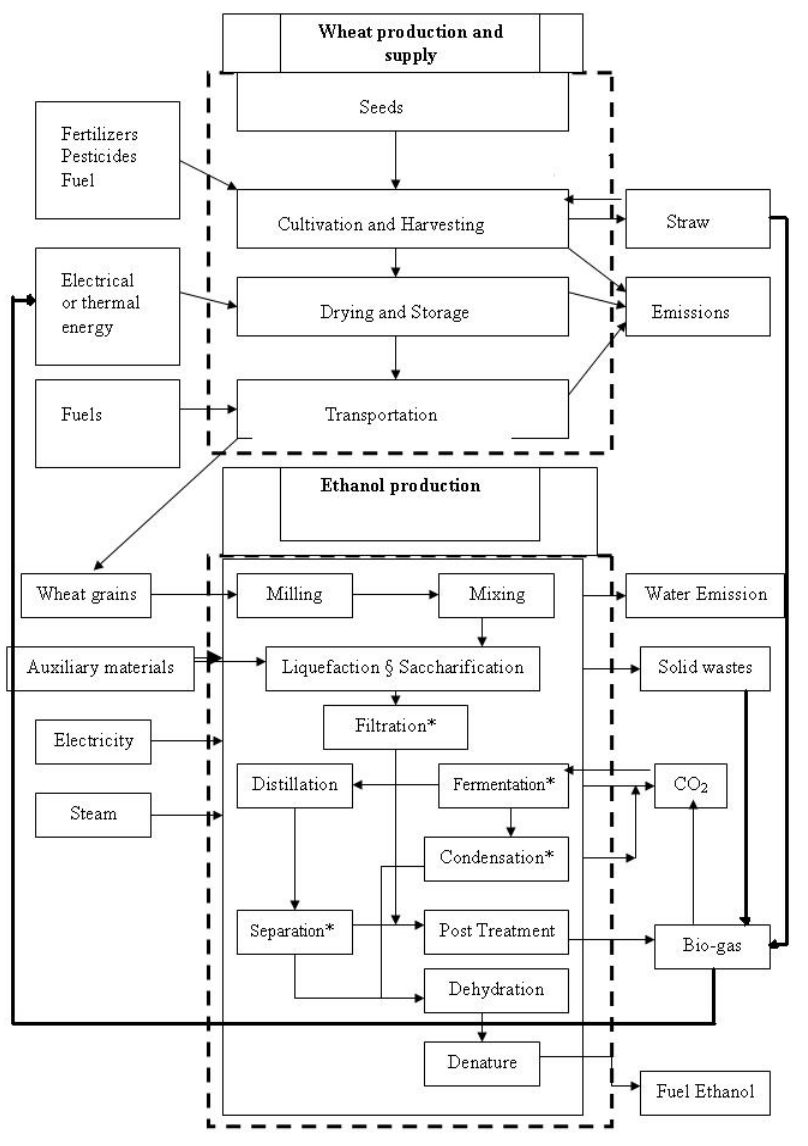
Figure 2. Production pathways for bio-ethanol with Blenke cascade system for Scenario